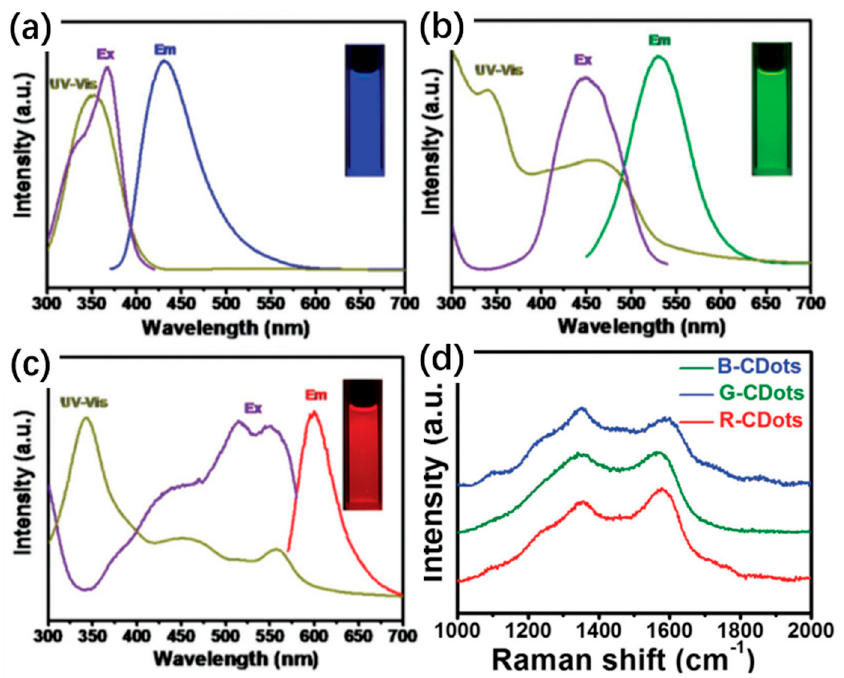
Figure 9. The photophysical properties of blue-, green-, and red-emitting of CDs in Ref. [63]. ( a – c ) UV-visible absorption, excitation, and emission, ( d ) Raman spectra. Reproduced from Ref. [63] with permission of Copyright (2018) John Wiley and Sons.